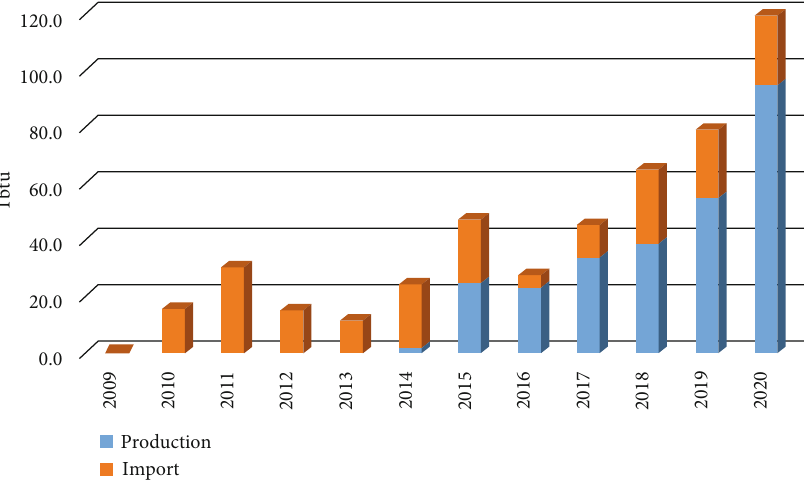
Figure 3: Annual production and imports of natural gas